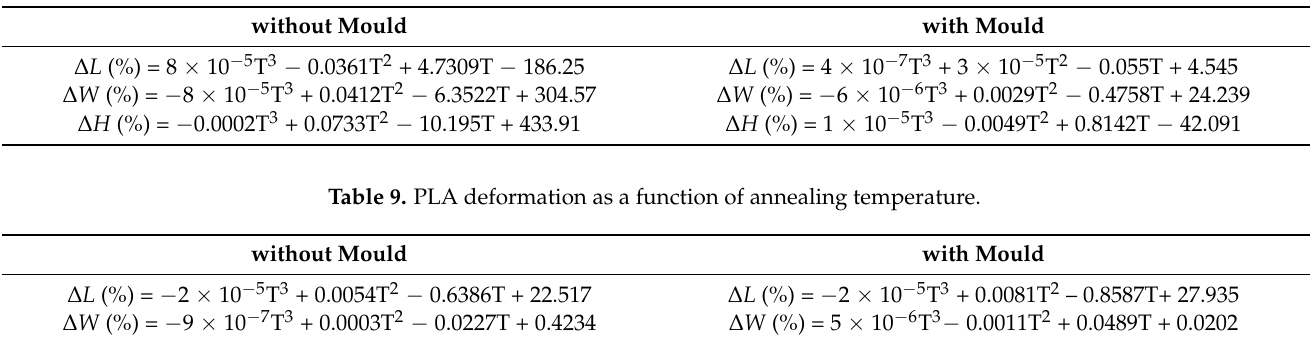
Figure 16. Mould effectiveness vs. annealing temperature third-degree polynomial approximation: ( a ) ABS; ( b ) PLA. Table 8. ABS deformation as a function of annealing temperature.